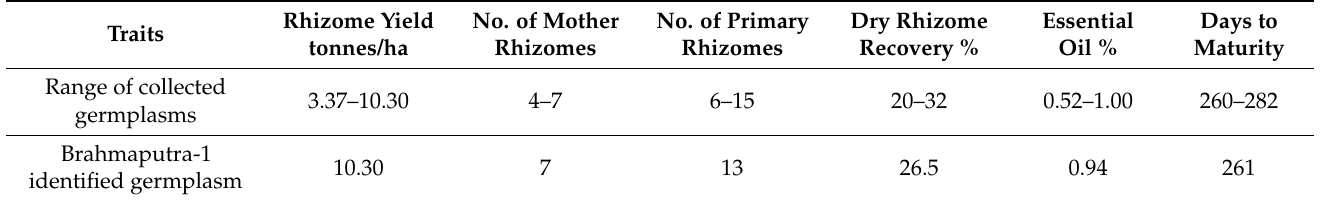
Table 2. Morpho-chemical traits of the collected K. galanga germplasms and the variety named